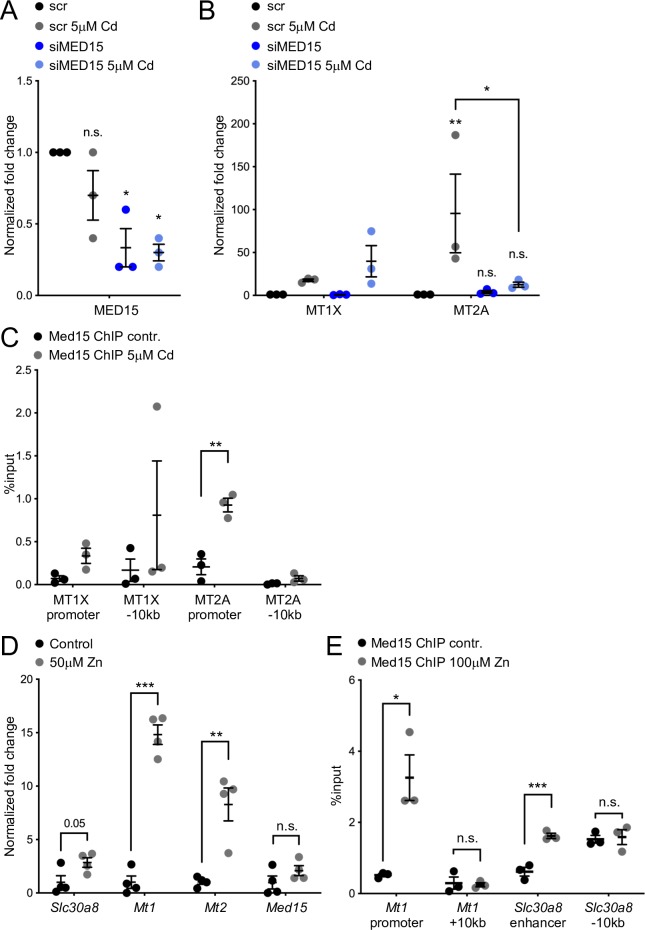
MED15 binds and regulates cadmium and zinc responsive genes in mammalian cells.[A] qRT-PCR analysis of MED15 mRNA in control (scr = scrambled siRNA) and MED15 siRNA (siMED15) treated A549 cells exposed to 5μM cadmium for four hours. Error bars: SEM; statistical analysis: * p < 0.05, One-way ANOVA, multiple comparison, Tukey correction, all comparisons to “scr” (n = 3 independent repeats). [B] qRT-PCR analysis of cadmium inducible genes in control (scr = scrambled siRNA) and MED15 siRNA (siMED15) treated A549 cells exposed to 5μM cadmium for four hours. Error bars: SEM; statistical analysis: * p < 0.05, ** p < 0.01, Two-way ANOVA, multiple comparisons, Tukey correction (n = 3 independent repeats). MT1X expression was not significantly affected. For MT2A, all comparisons are vs. “scr”, except where indicated by lines. [C] The graph shows relative MED15 occupancy at the MT1X and MT2A promoters and nearby control regions in A549 cells, as determined by ChIP-qPCR before and after the addition of 5μM cadmium. Error bars: SEM; statistical analysis: ** p < 0.01 Student’s t-test, multiple comparisons, Holm-Sidak correction (n = 3 independent repeats). [D] The graph shows qRT-PCR analysis of MIN6 cells treated without and with 50μM zinc. Error bars: SEM; statistical analysis: ** p < 0.01, *** p < 0.001 Student’s t-test, multiple comparisons, Holm-Sidak correction (n = 4 independent repeats). [E] The graph shows relative Med15 occupancy at the Mt1 promoter and Slc30a8 enhancer and nearby control regions in MIN6 cells as determined by ChIP-qPCR, before and after the addition of 100μM Zn. Error bars: SEM; statistical analysis: * p < 0.05, *** p < 0.01 Student’s t-test, multiple comparisons, Holm-Sidak correction (n = 3 independent repeats).